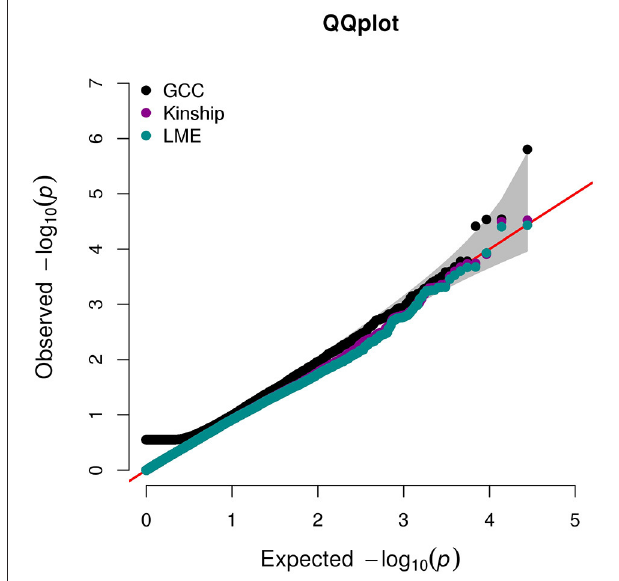
FIGURE 1 | QQ plot for single mRNA probe analysis from GCC, kinship, and LME